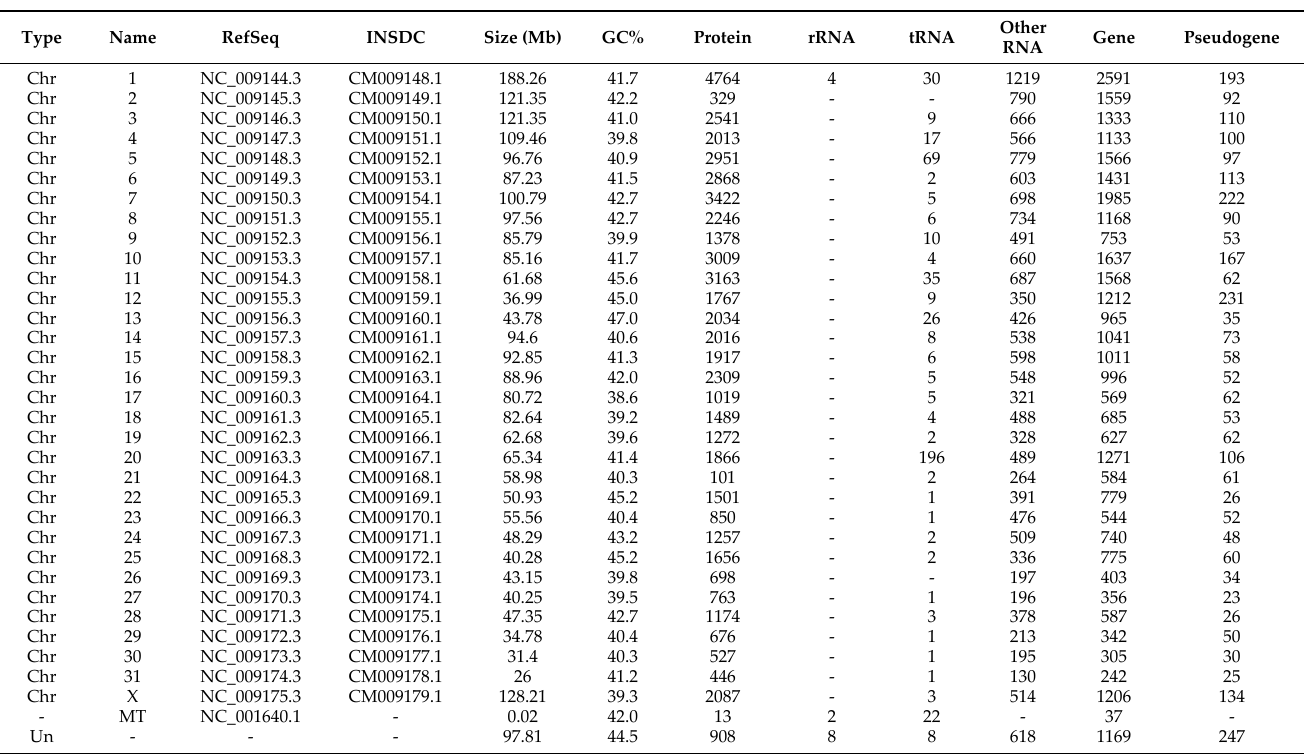
Table 1. Genome information for reference and representative genomes of horse